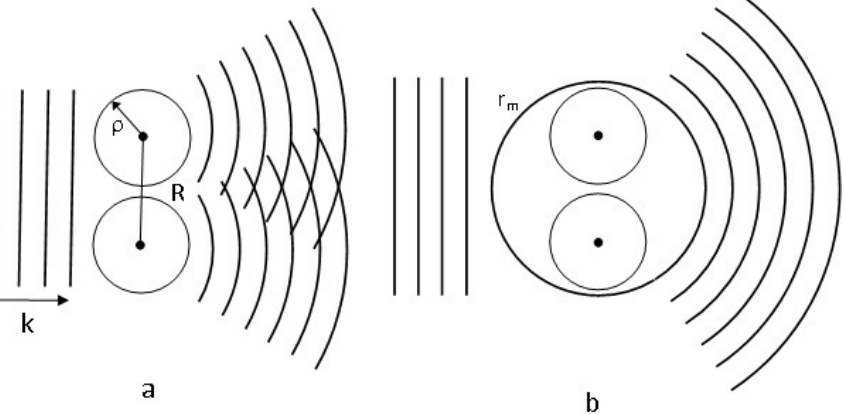
Figure 1. The qualitative picture of the electron wave scattering by a diatomic target; ( a ) is the Huygens–Fresnel picture; ( b ) is the Dill and Dehmer picture